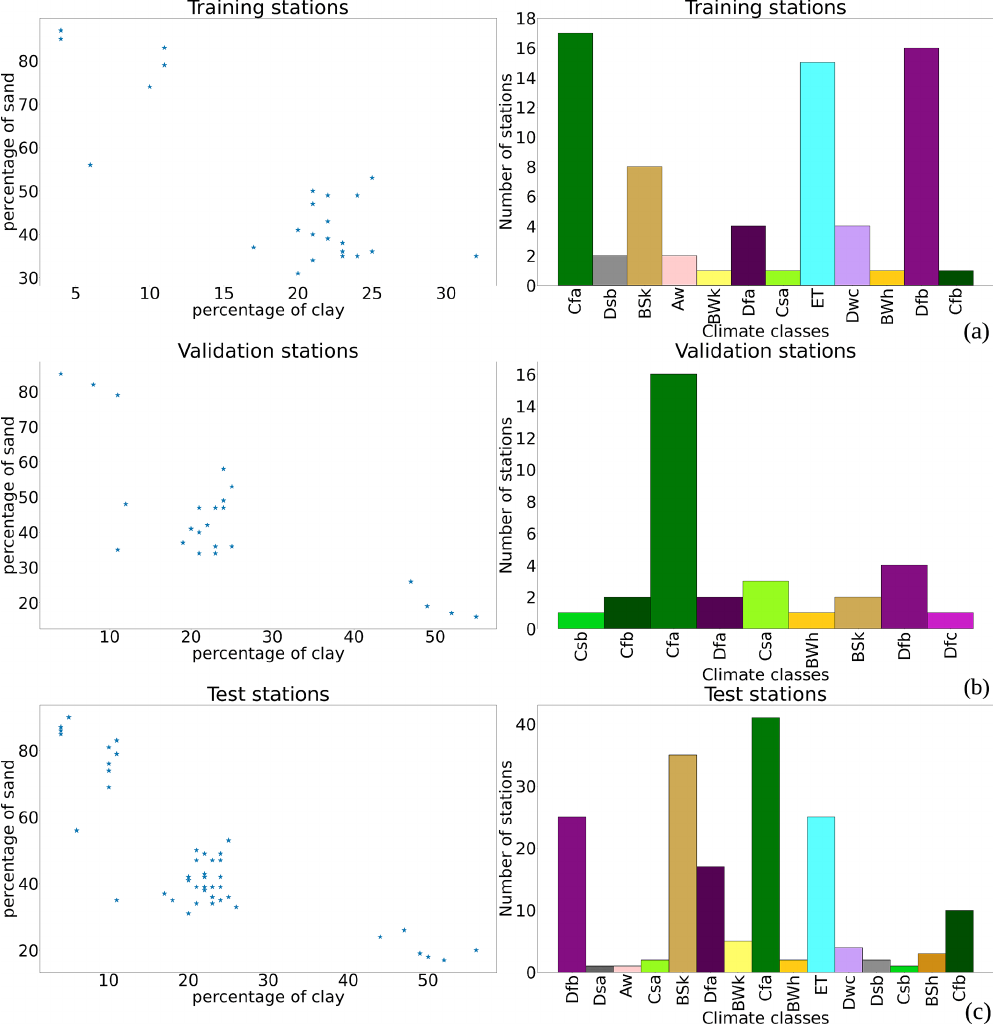
Figure B1. Climate and soil texture for (a) training stations, (b) validation stations and (c) test